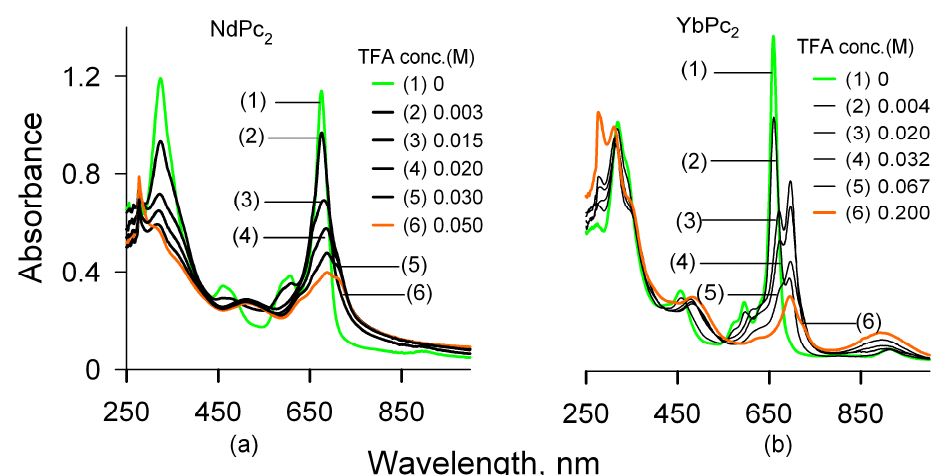
Figure 2. Formation of the TFA conjugates (orange form) with ( a ) NdPc 2 and ( b ) YbPc 2 traced by spectrophotometric measurements in the UV-Vis range. The TFA concentration necessary to produce the maximum amount of the Yb-conjugate is 4 × higher than in the case of Nd. Molecules 2020 , 25 , x FOR PEER REVIEW